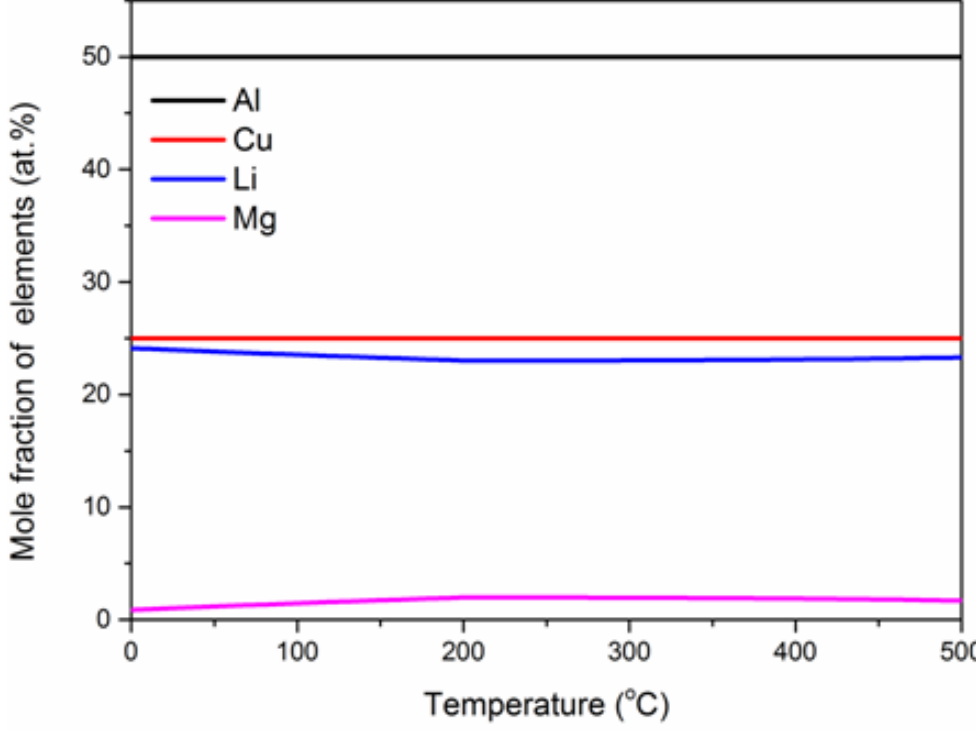
Figure 12. The content of elements in θ ’-Al2Cu phase.